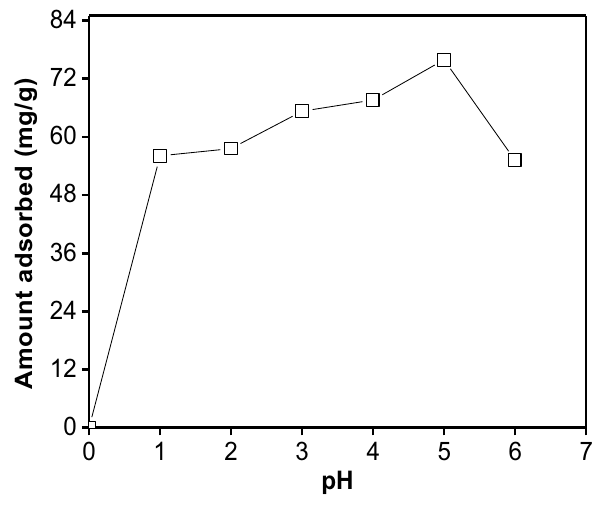
Fig.7 Effect of initial pH on Pb(II) adsorption ([Pb] adsorbent dosage = 0.2 g/L, time = 120 min, T = 25 ± 2